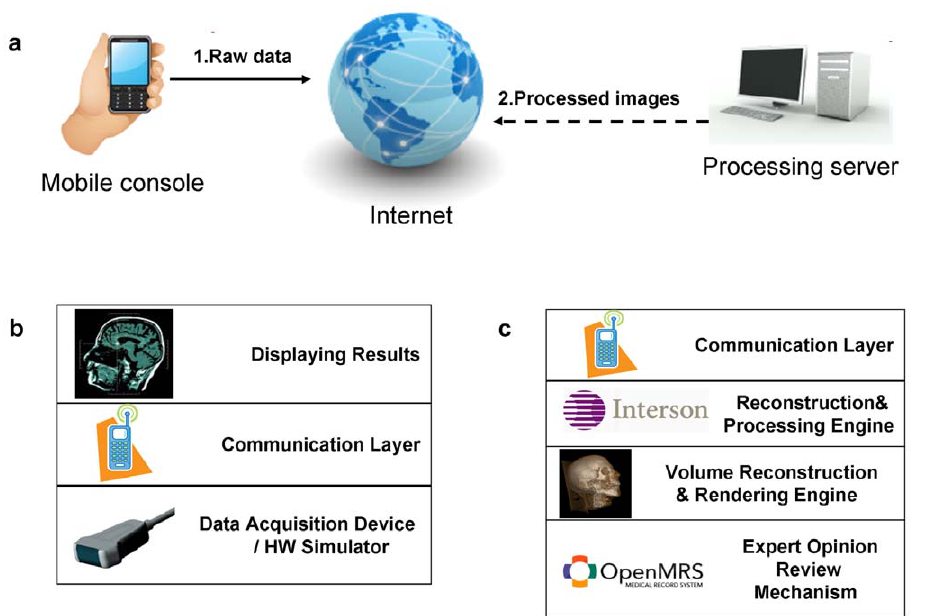
Figure 1. System Architecture. (a) Overall system architecture includes the mobile console component and the remote processing server (Expert System) which performs the computation-extensive work. (b) Mobile Console Architecture. The console has one or more data acquisition devices, a communication module and a display capability. (c) Server Architecture. Contains a communication module, a processing engine, a visualization engine and an expert assessment mechanism.